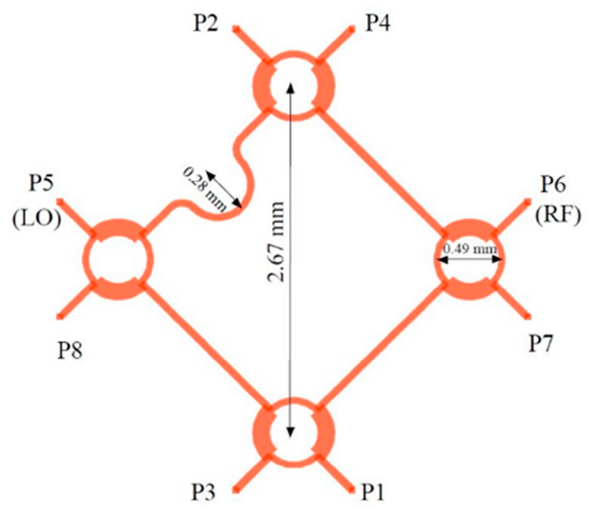
Figure 11. Microstrip multi-port layout.